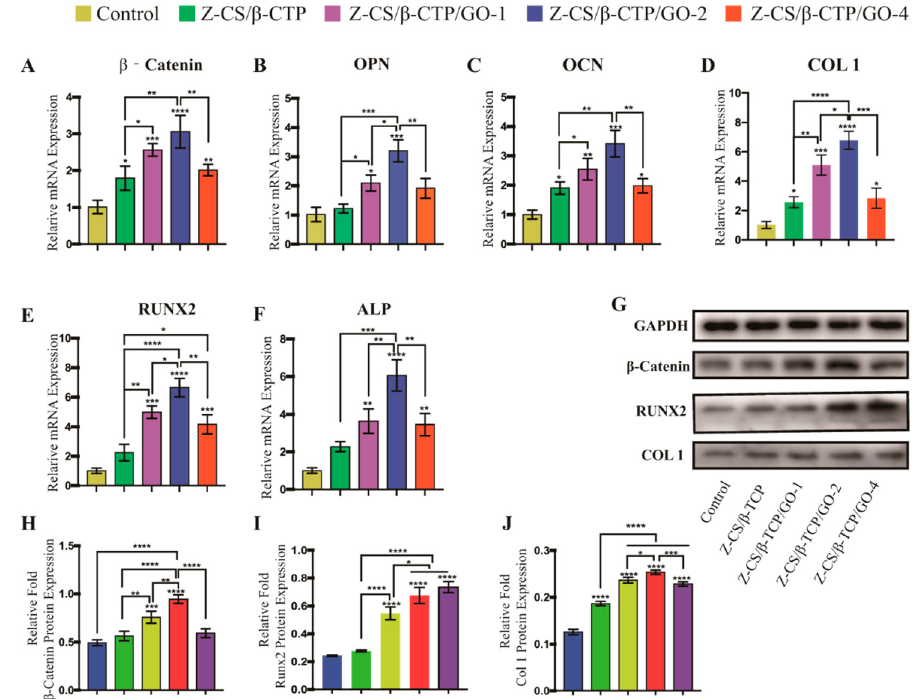
Figure 5. Expression levels of osteogenic genes β -catenin ( A ), OPN ( B ), OCN ( C ), COL 1 ( D ), RUNX2 ( E ), and ALP ( F ) tested by qRT-PCR. Osteogenic proteins ( G ) analyzed by western blot- ting. ( H – J ) Quantification results of β -catenin, RUNX2, and COL-1 (* p < 0.05, ** p < 0.01, *** p < 0.001, and **** p < 0.0001).